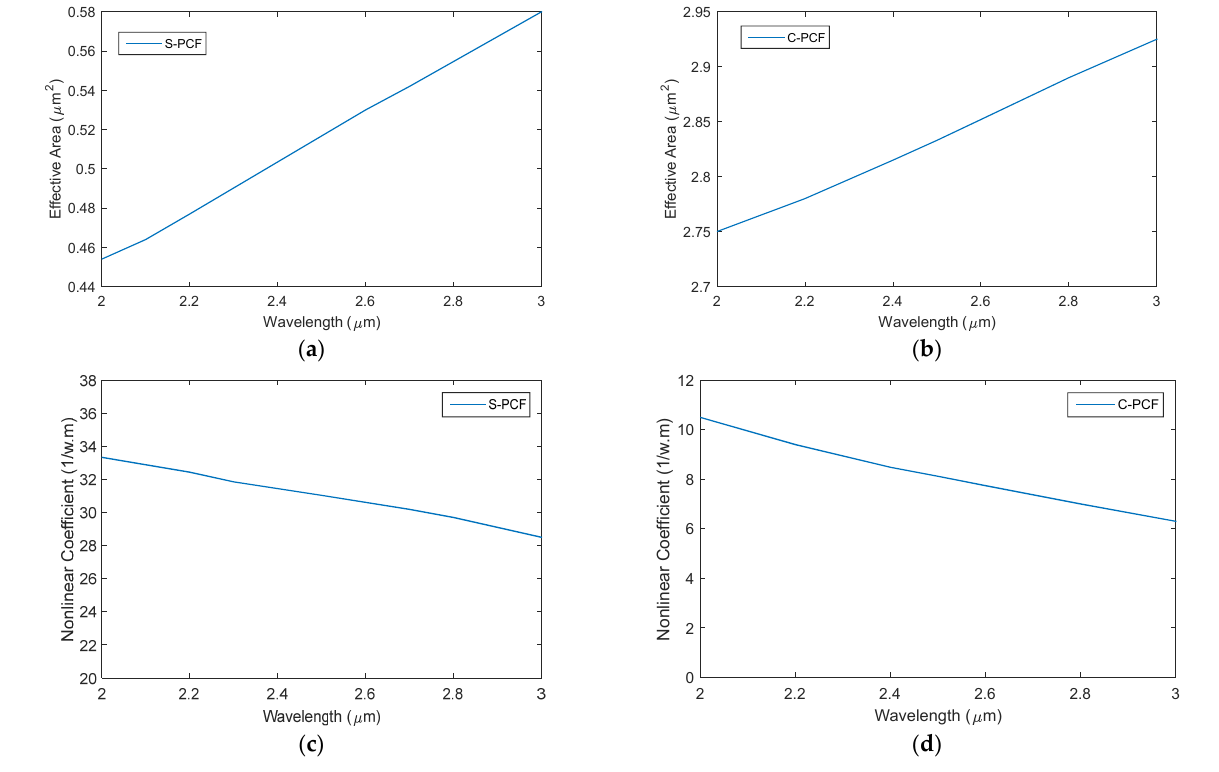
Figure 4. Effective areas and nonlinear coefficients for ( a , b ) entirely silicon PCF and ( c , d ) silicon-core and silica-doped-with-fluorine (1%) cladding PCF with Λ = 0.75 µ m, d / Λ = 0.8 and Λ = 2.5 µ m, d / Λ = 0.8,